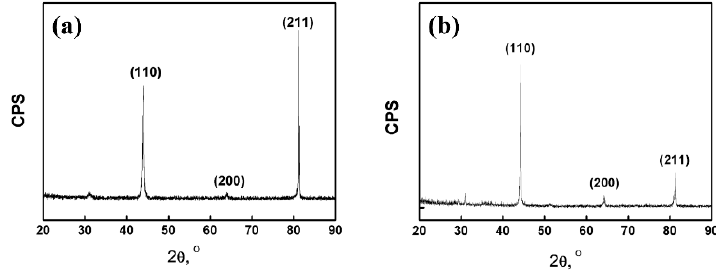
Figure 3. Surface morphology observed in an optical microscope: ( a ) as‐cast alloy; ( b ) hot‐rolled alloy. Figure 4. X‐ray diffraction: ( a ) as‐cast alloy; ( b ) hot‐rolled alloy.